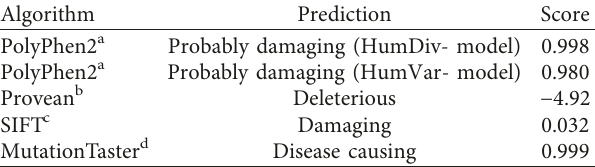
Table 1: Results of in silico mutation prediction analysis.